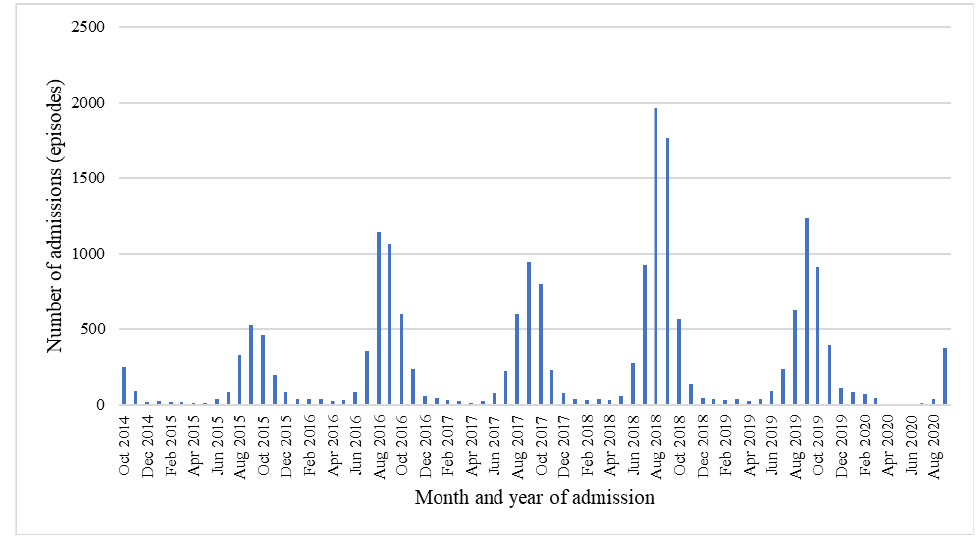
Figure 1. Monthly climate trends of RSV-related LRTI admissions in children from fiscal years 2015 to 2020.